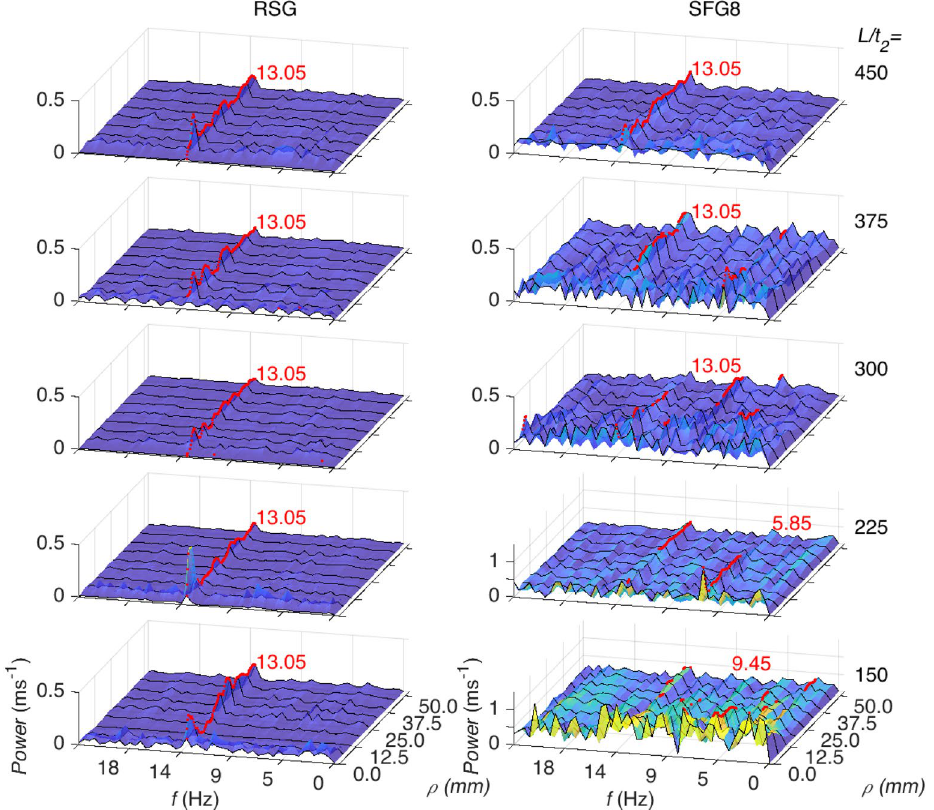
Figure 3. Power spectrum at each streamwise distance at all concentric square, ρ for RSG (left) and SFG8 (right). The peak of each ρ is shown as red dots with the most dominant indicated in red text. (note: prepared in Matlab R2018A, https:// www. mathw orks. com/ produ cts/ matlab.